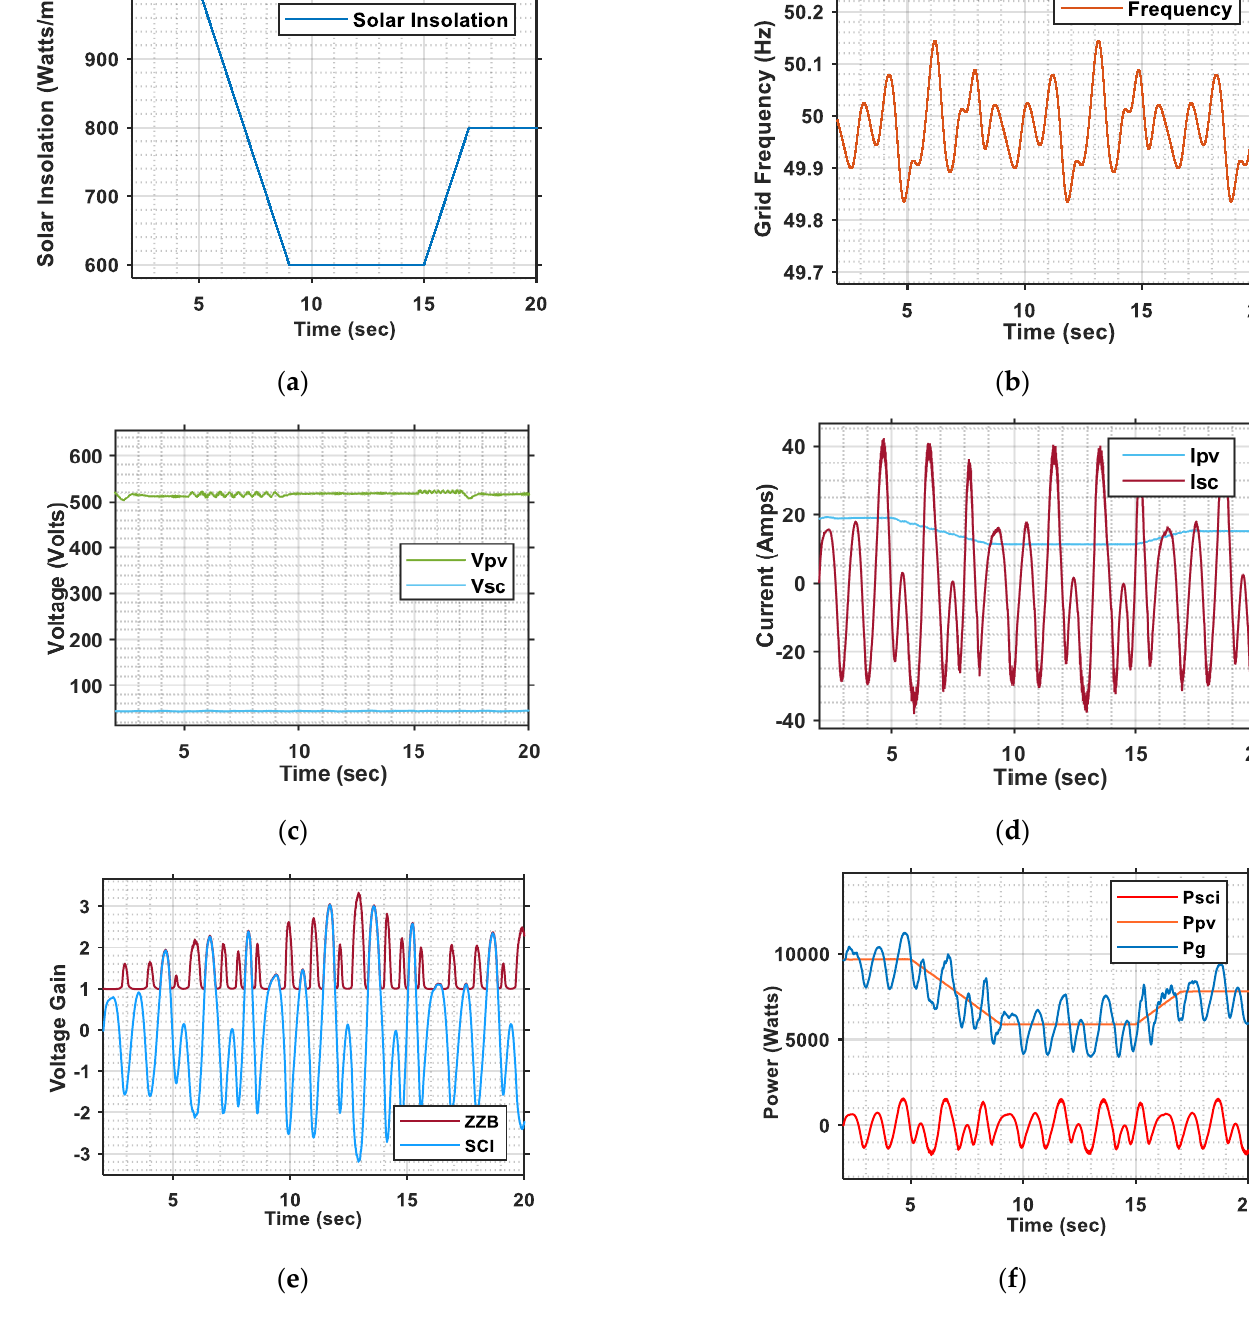
Figure 21. MATLAB simulation results for SIR based on variable solar insolation: ( a ) variation in solar insolation profile as an input; ( b ) low-frequency variation in Grid Frequency; ( c ) variation in PV and SC voltage; ( d ) variation in PV and SC current; ( e ) voltage gain of the SC-PPS; ( f ) output power of SC, PV and the grid power profile.